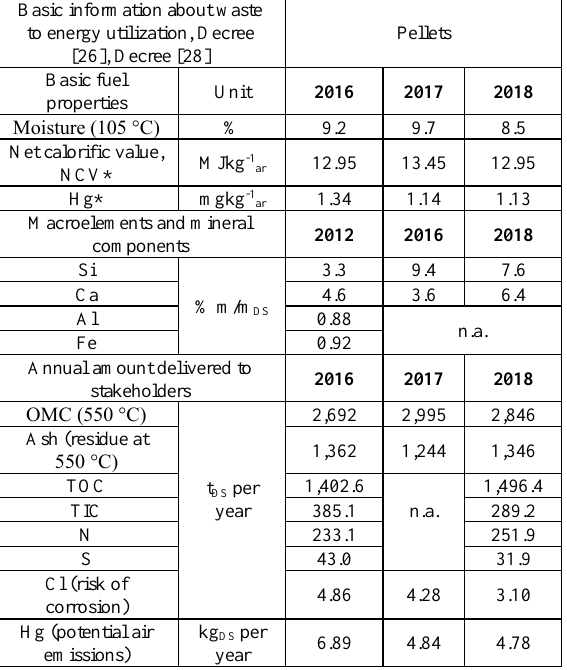
Table 11. Proximate and ultimate analysis of pellets as a source of energy Basic information about waste to energy utilization,